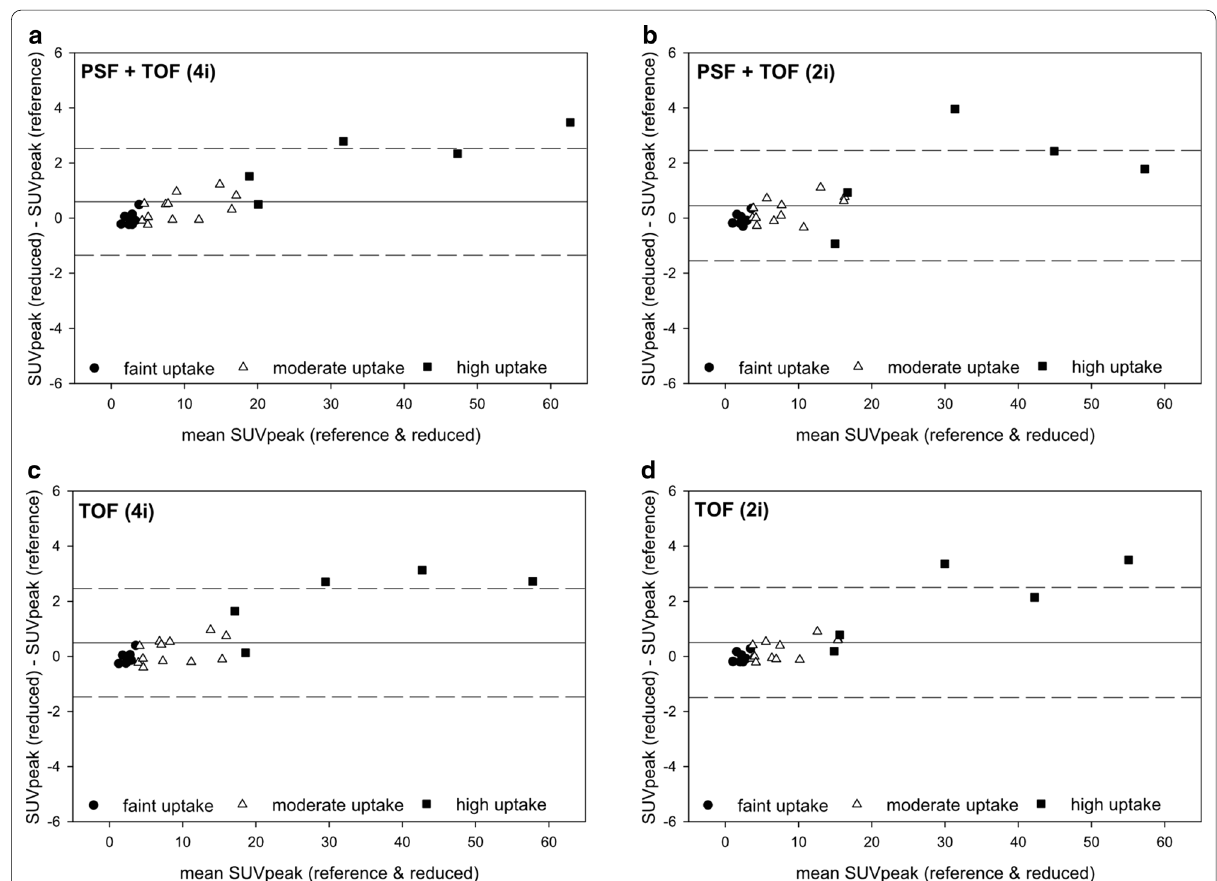
Fig. 5 Bland–Altman plots showing the agreement of SUVpeak between images acquired with reduced vs. standard emission time reconstructed with PSF TOF (4i, panel a ) PSF TOF (2i, panel b ), TOF (4i, panel c ), and TOF (2i, panel d ). A systematic overestimation of high-uptake lesions was + +